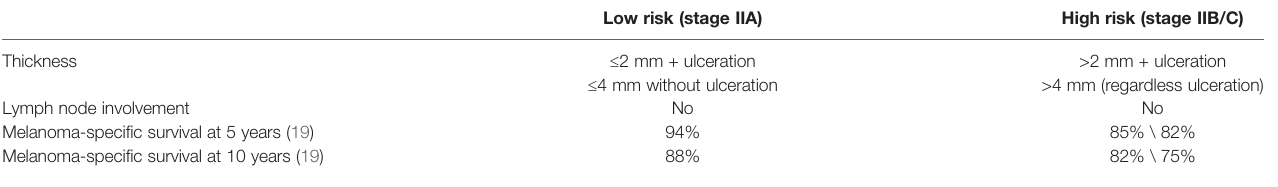
TABLE 2 | Low- and high-risk stage II melanoma